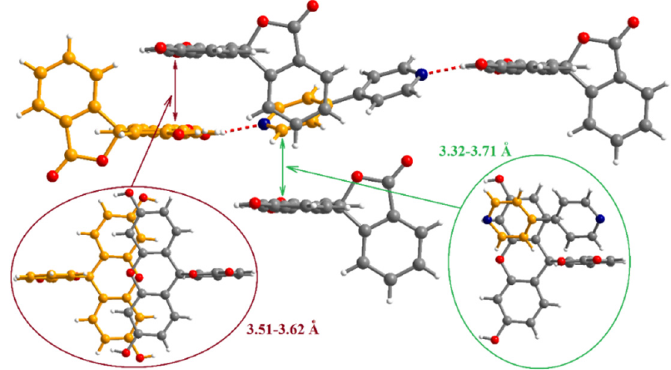
Figure 3. Details of the π - π interactions established in crystal 1 .